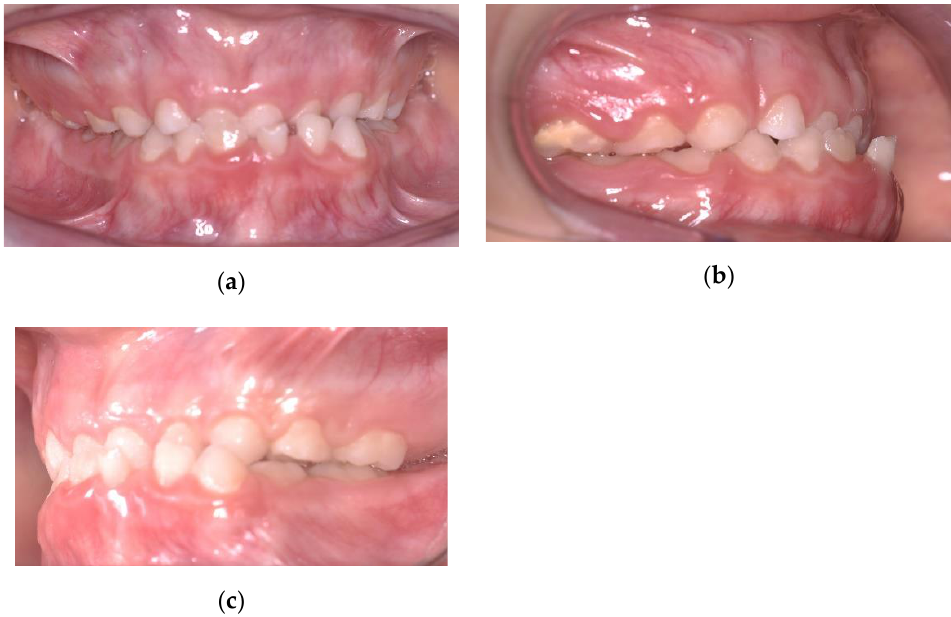
Figure 2. Intraoral pretreatment pictures: ( a ) frontal view; ( b ) lateral view of right side; ( c ) lateral view of left side.